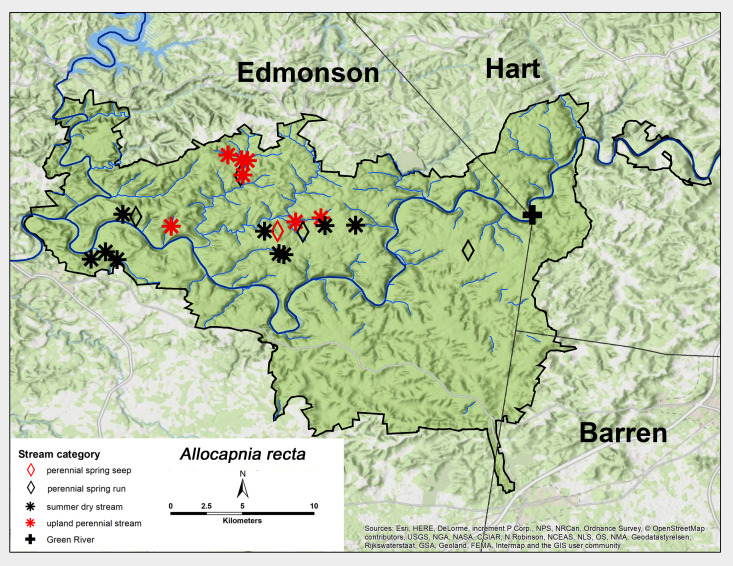

Allocapnia
recta